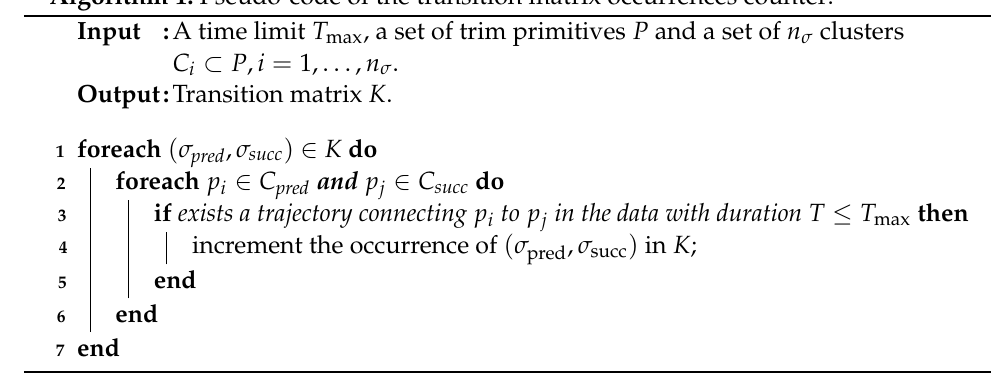
Algorithm 1: Pseudo-code of the transition matrix occurrences